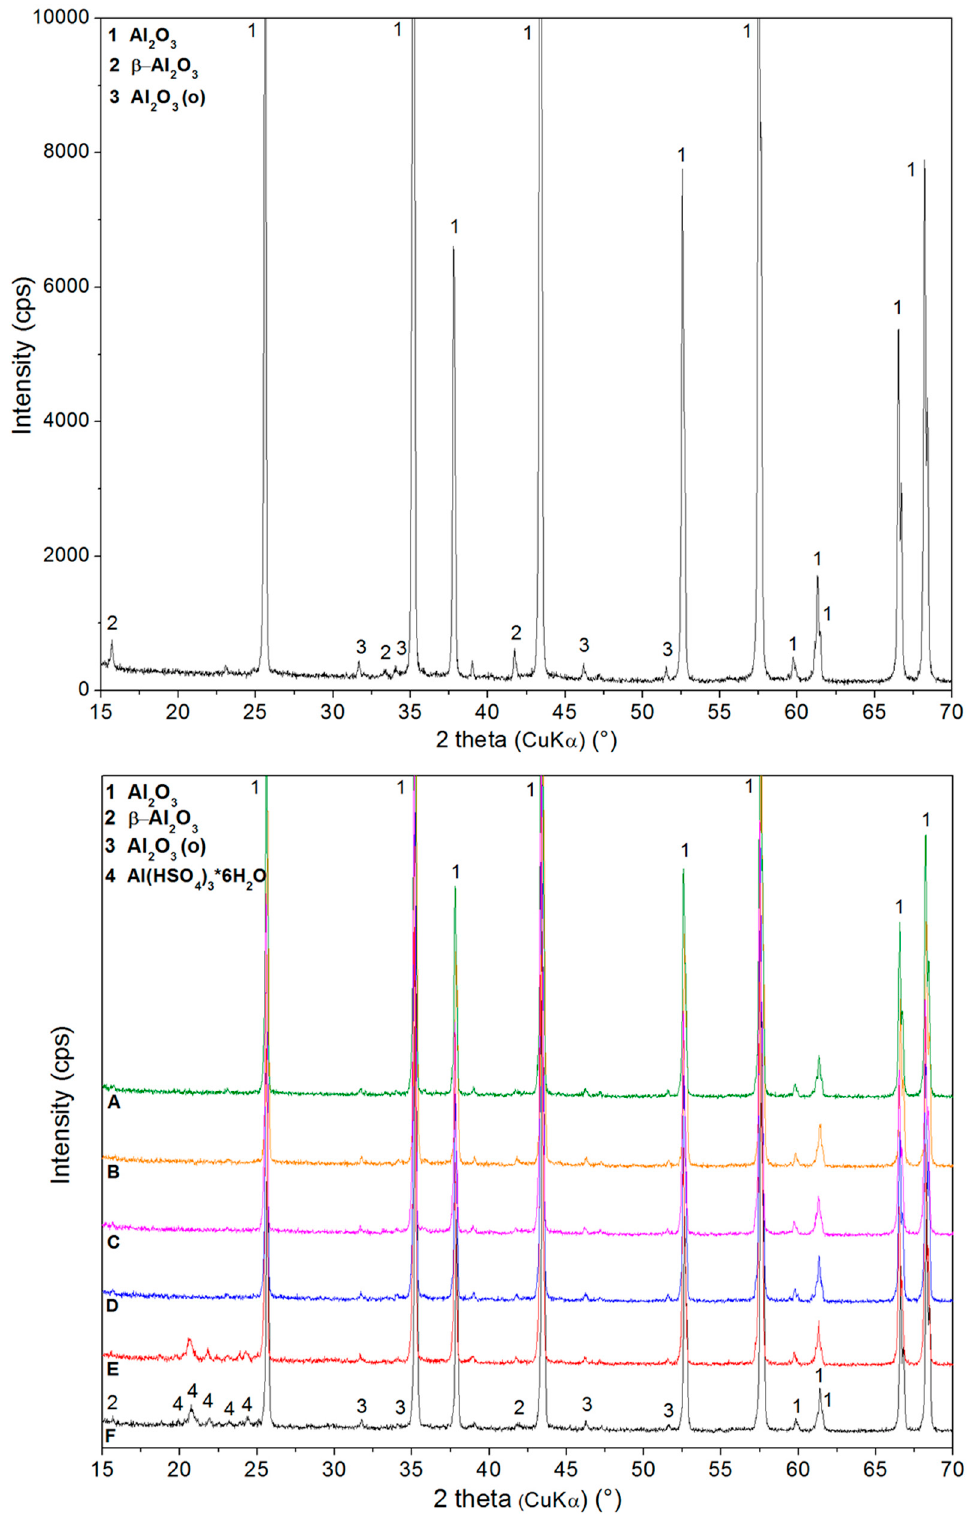
Figure 8. XRD patterns for alumina: as received sample (top) and modified samples (bottom). (A) Al2O3_HF0.15_120; (B) Al2O3_HF0.15_60; (C) Al2O3_SN1_120; (D) Al2O3_SN1_60; (E) Al2O3_PS1_120; (F) Al2O3_PS1_60; where peaks of evaluated phases are mentioned in the pattern.